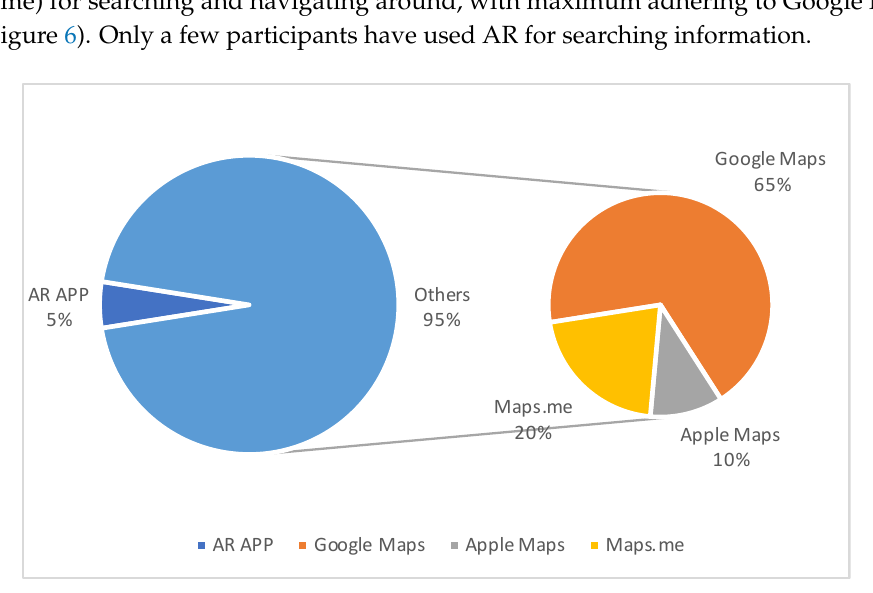
Figure 6. Applications used by the participants for searching